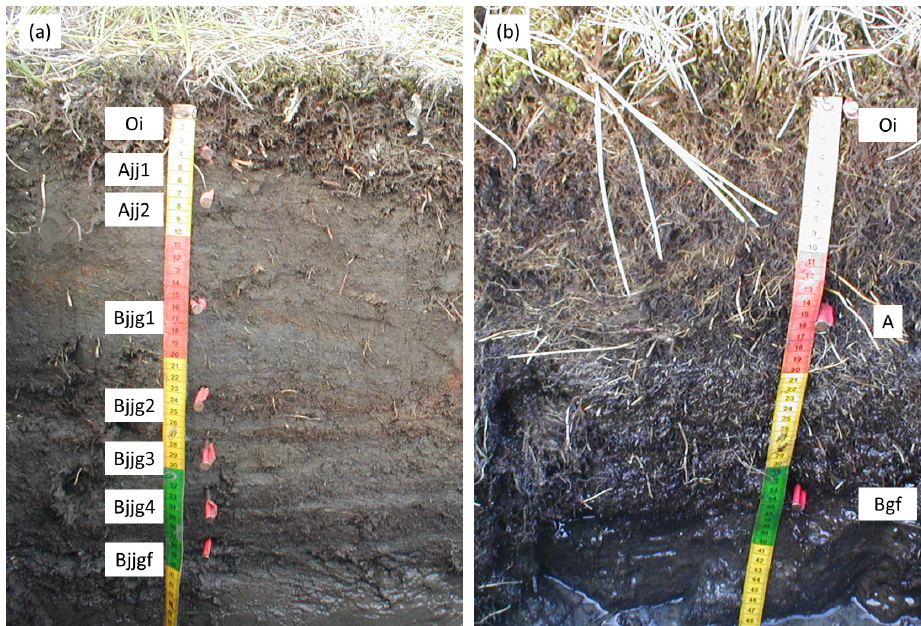
Figure F1. Photographs of soil profiles (a) BS-1 ( Typic Aquiturbel ) at the peak of a polygon rim and (b) BS-3 ( Typic Historthel ) at a polygon centre. Designations of soil horizons according to US Soil Taxonomy (Soil Survey Staff, 2010). Horizon labels are positioned at the upper boundary of the respective